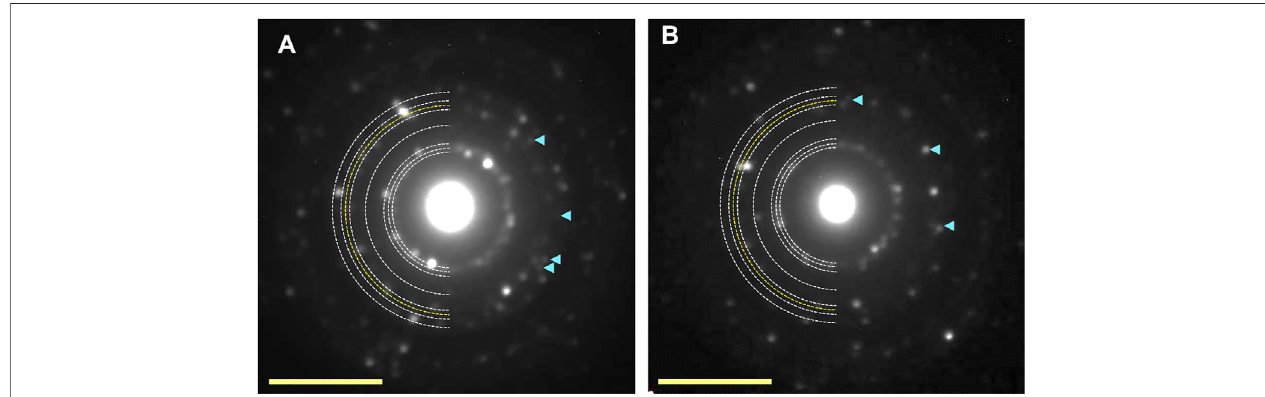
FIGURE 7 | Electron diffraction patterns of 60-min. UV-irradiated ice Ih at 120 K (A) and 140 K (B) . The appearance of additional diffraction spots shown by pale blue arrowheads can be indexed as the 131 diffractions of ice XI. Yellow scale bars, 5 nm − 1 .